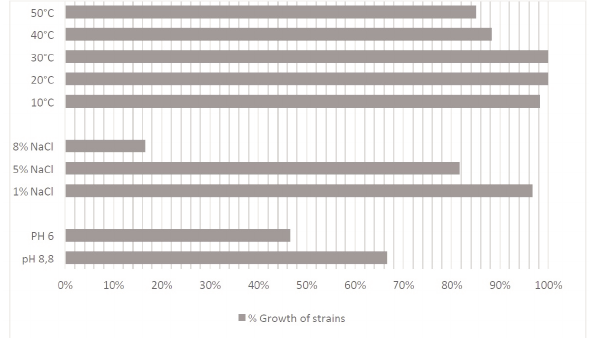
Fig. 3 - Estimation of tolerance of PGPR strains to alkalinity, aci- dity, salinity and temperature.